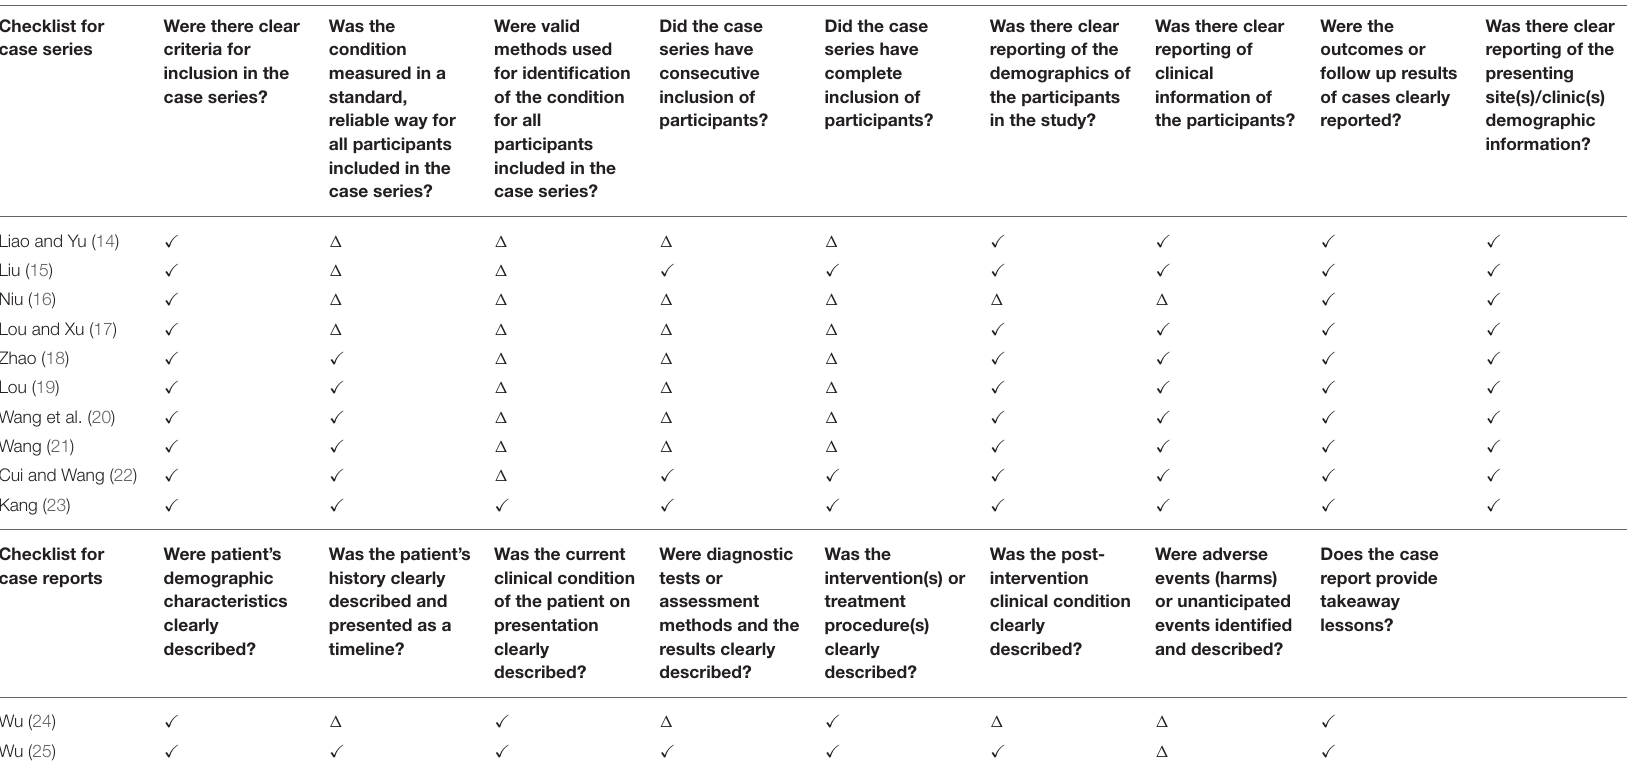
TABLE 2 | Quality assessment of included studies. Checklist for case